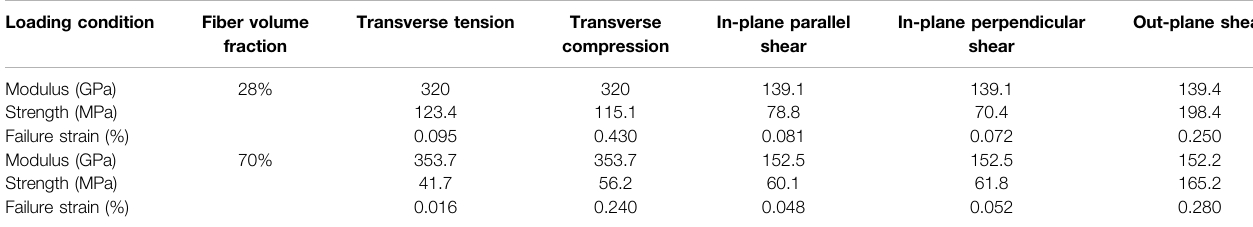
TABLE 1 | The predicted tansverse fi ber properties for SiC f /SiC micro-UD model. Loading